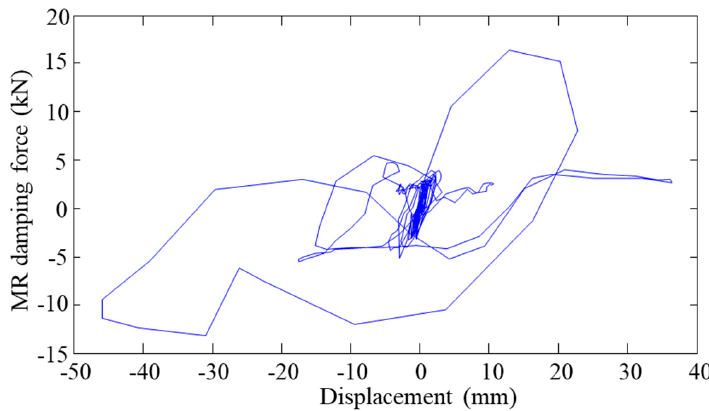
Figure 18. MR damper hysteretic curve.